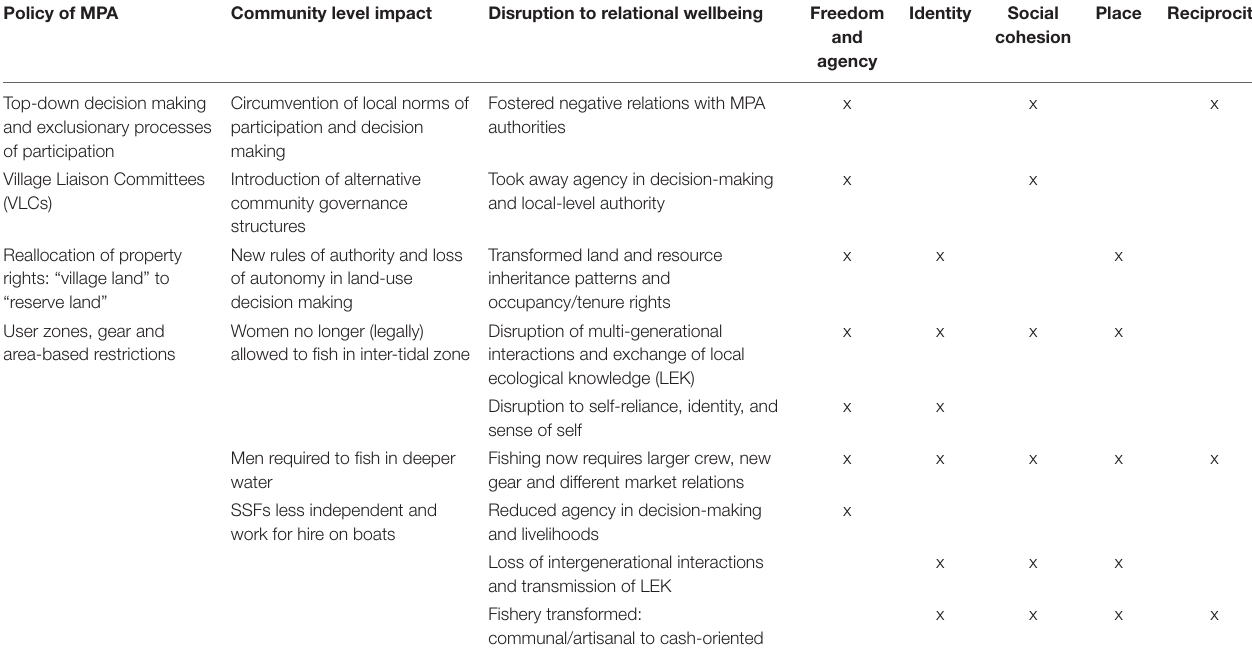
TABLE 2 | Primary interactions between, and impacts of, the MPA policy/action and small-scale fisher’s relational wellbeing and relational values. Policy of